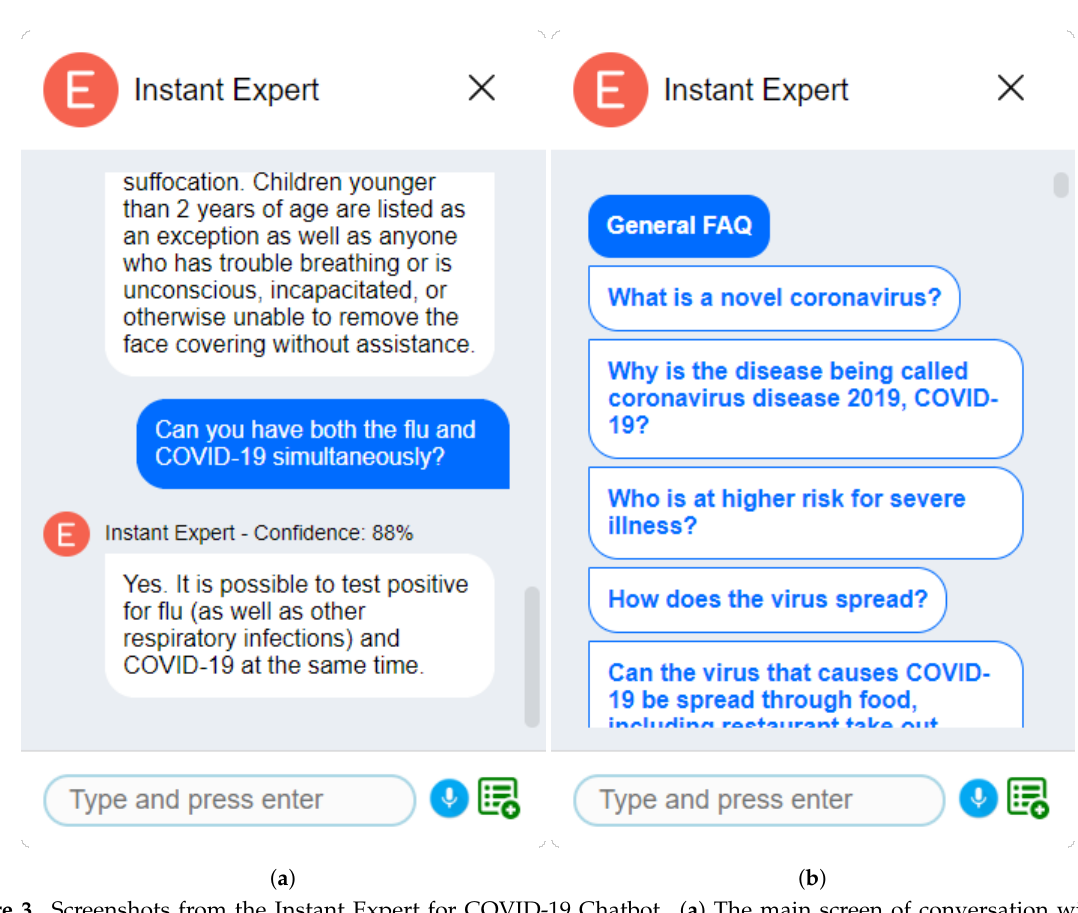
Figure 3. Screenshots from the Instant Expert for COVID-19 Chatbot. ( a ) The main screen of conversation with but- tons to activate voice input and display example questions, ( b ) example questions that can be asked to the chatbot as recommendations to the